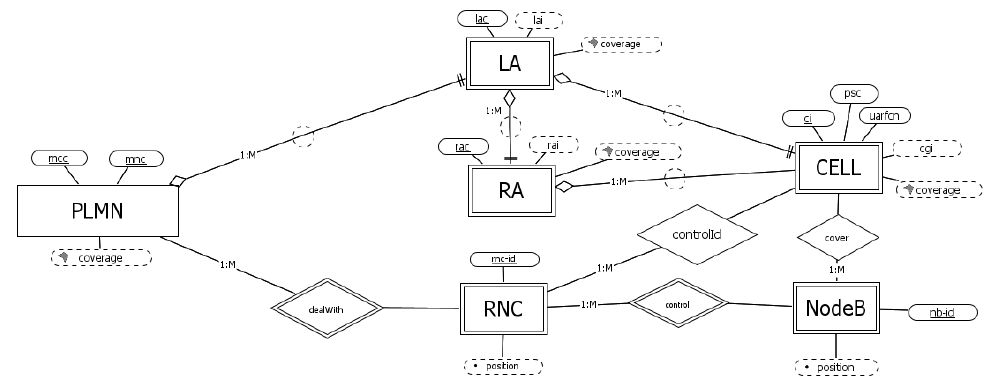
Figure 4. Conceptual schema for UMTS